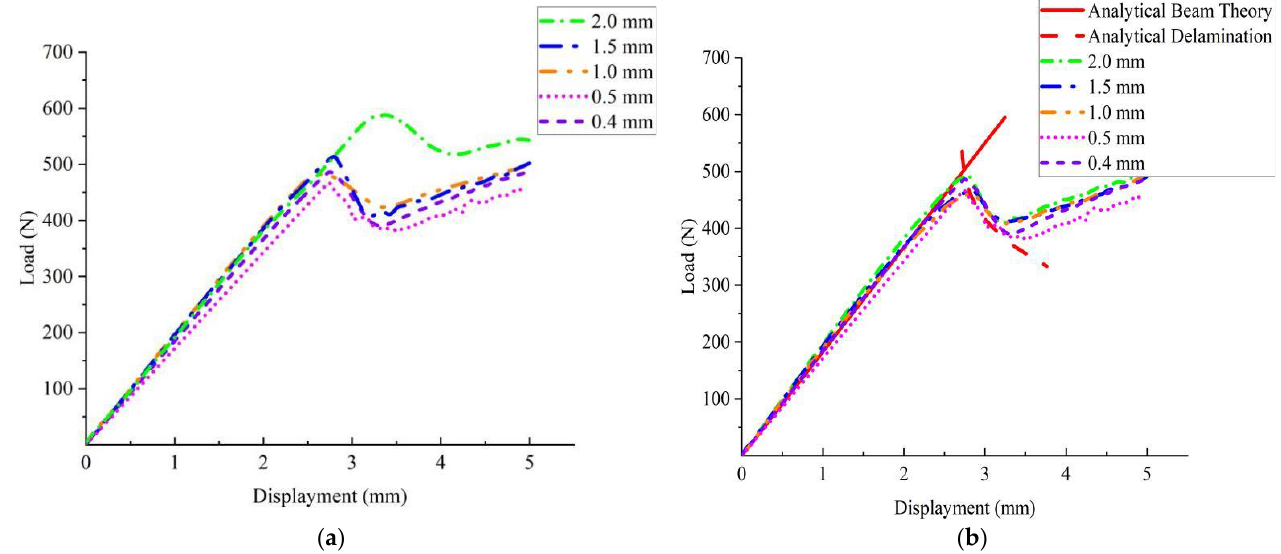
Figure 9. Model II delamination failure based on the tiebreak contact algorithm correction. ( a ). Uncorrected load – displacement curve; ( b ). corrected load – displacement curve.